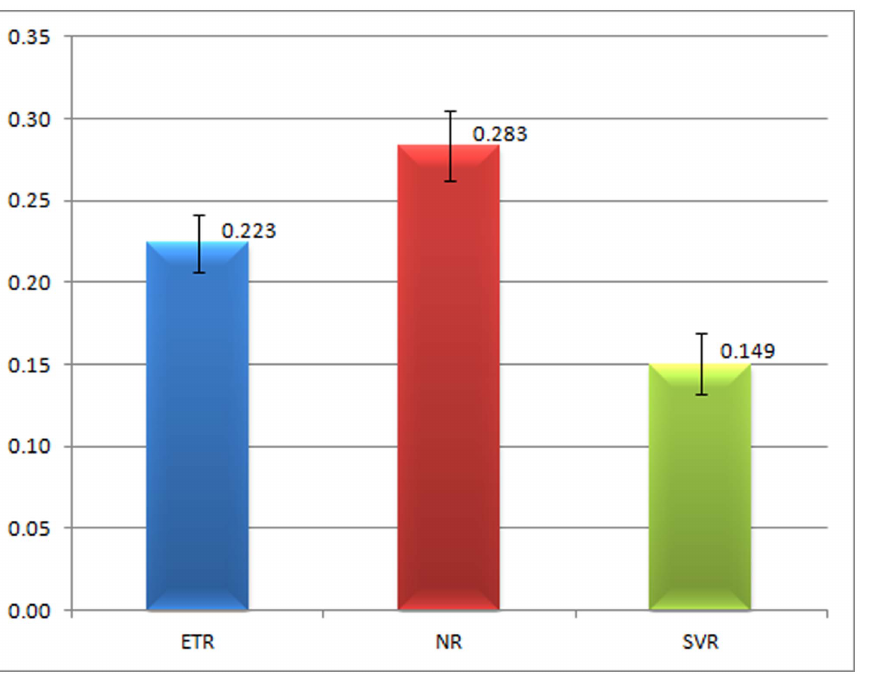
Figure 3. Overall v . Overall v of each response group. ETR: end-of-treatment responder; NR: non-responder; SVR: sustained virological responder.